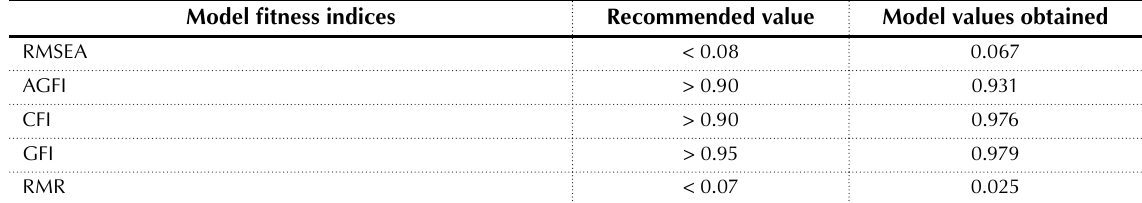
Table 4. Goodness of fit for SEM